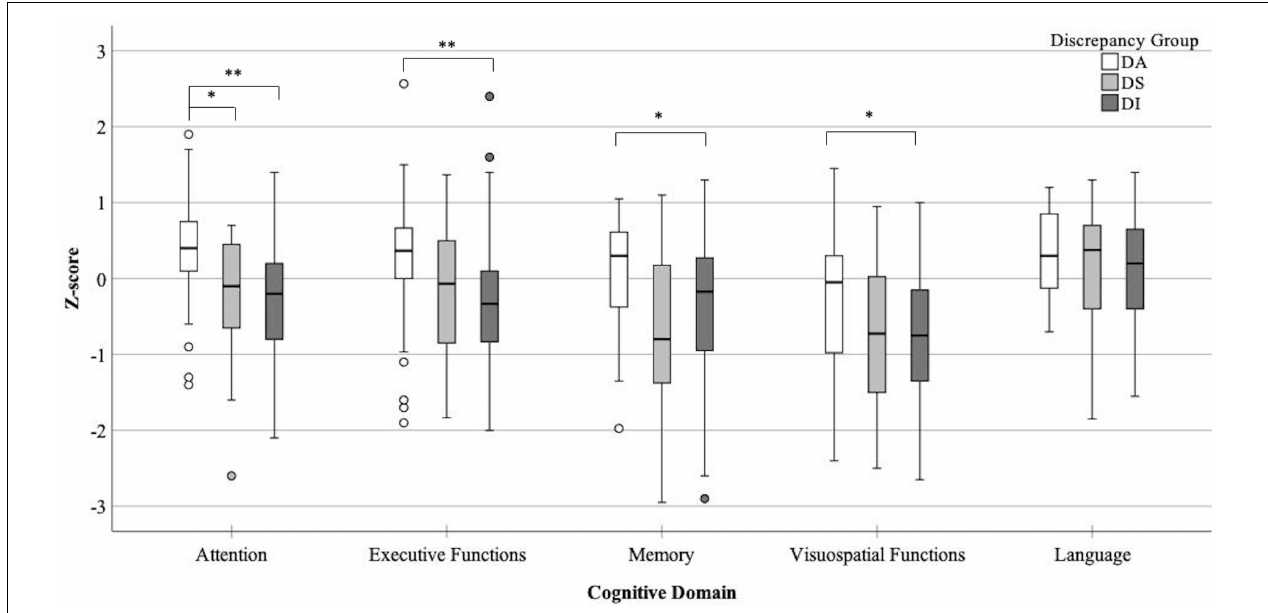
FIGURE 1 | Box-and-whisker plot detailing performance across all five cognitive domains for each discrepancy score group (DA- perfect agreement between informants and patients, DS- higher impairment rated by patients, DI- higher impairment rated by informants), ∗ p < 0.05, ∗∗ p <